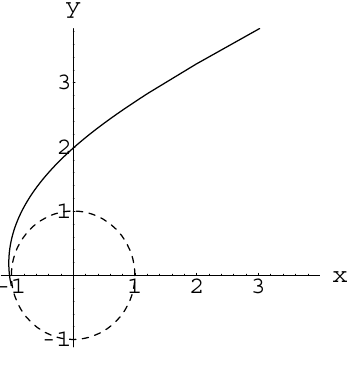
Fig. 4. When u 3 ≤ 0, the tra- jectory, starting on the circle r = 1 /u 2 tends to infinity. The graph is shown for σ = 1 , γ = 1 , δ = 1 , h = 1 , u 2 =